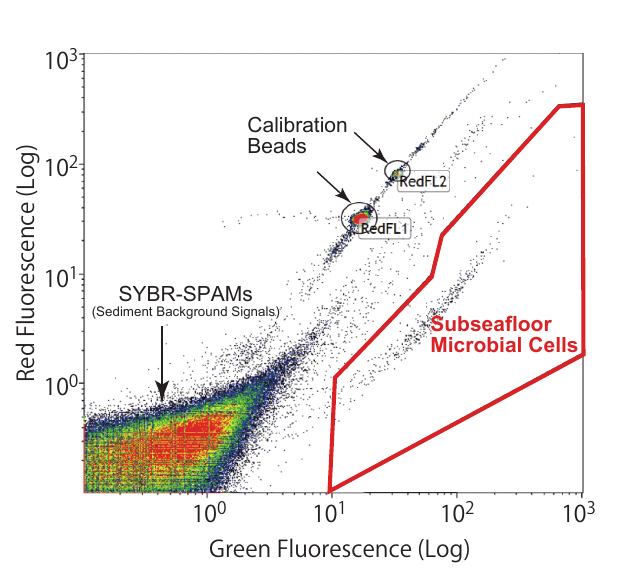
Figure 1. Standardization of cell counting techniques. The deter- mination of cell abundance is a basic measurement common to most subsurface microbial community descriptions. An automated flow cytometer system can be used to determine cell abundances with high reproducibility and at a high sample rate (Morono et al., 2008). This method can be used repeatedly at multiple drill sites to reduce human errors and provide better connectivity between projects. (Figure is being used with permission from Yuki Morono; Morono et al.,